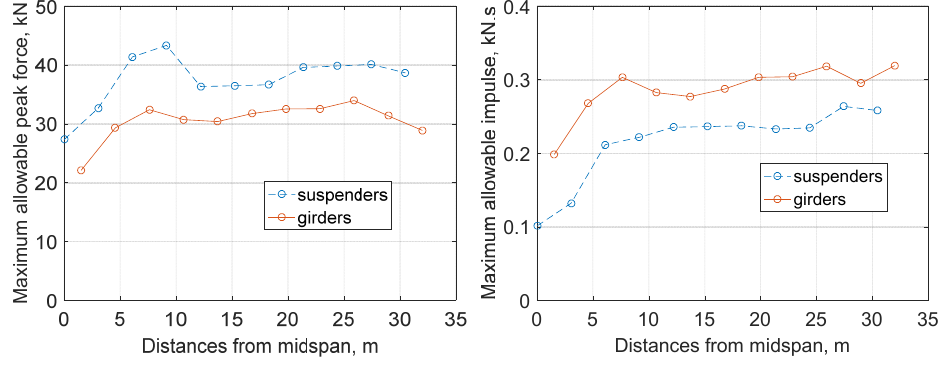
Figure 13. Maximum allowable impact force and impulse.